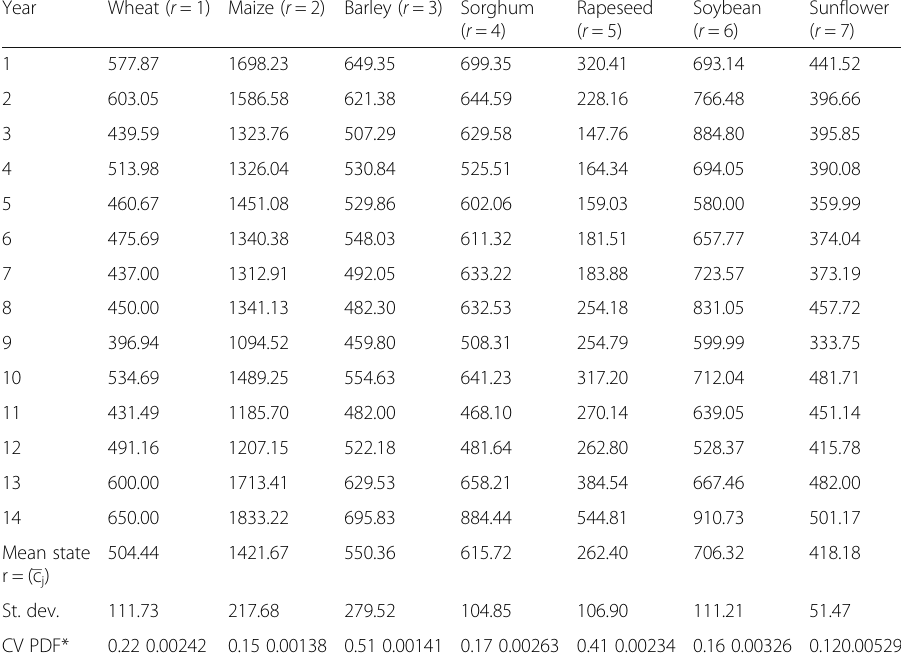
Table 2 Crop vectors of GI ( € /Ha) representing the risky prospects of seven crops for 14 years of